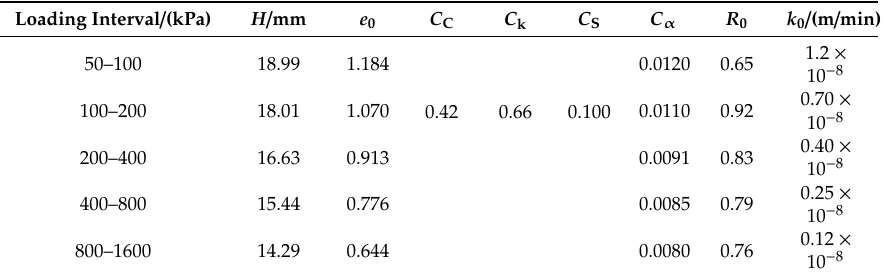
Table 6. UH model parameters of sample LB-1.